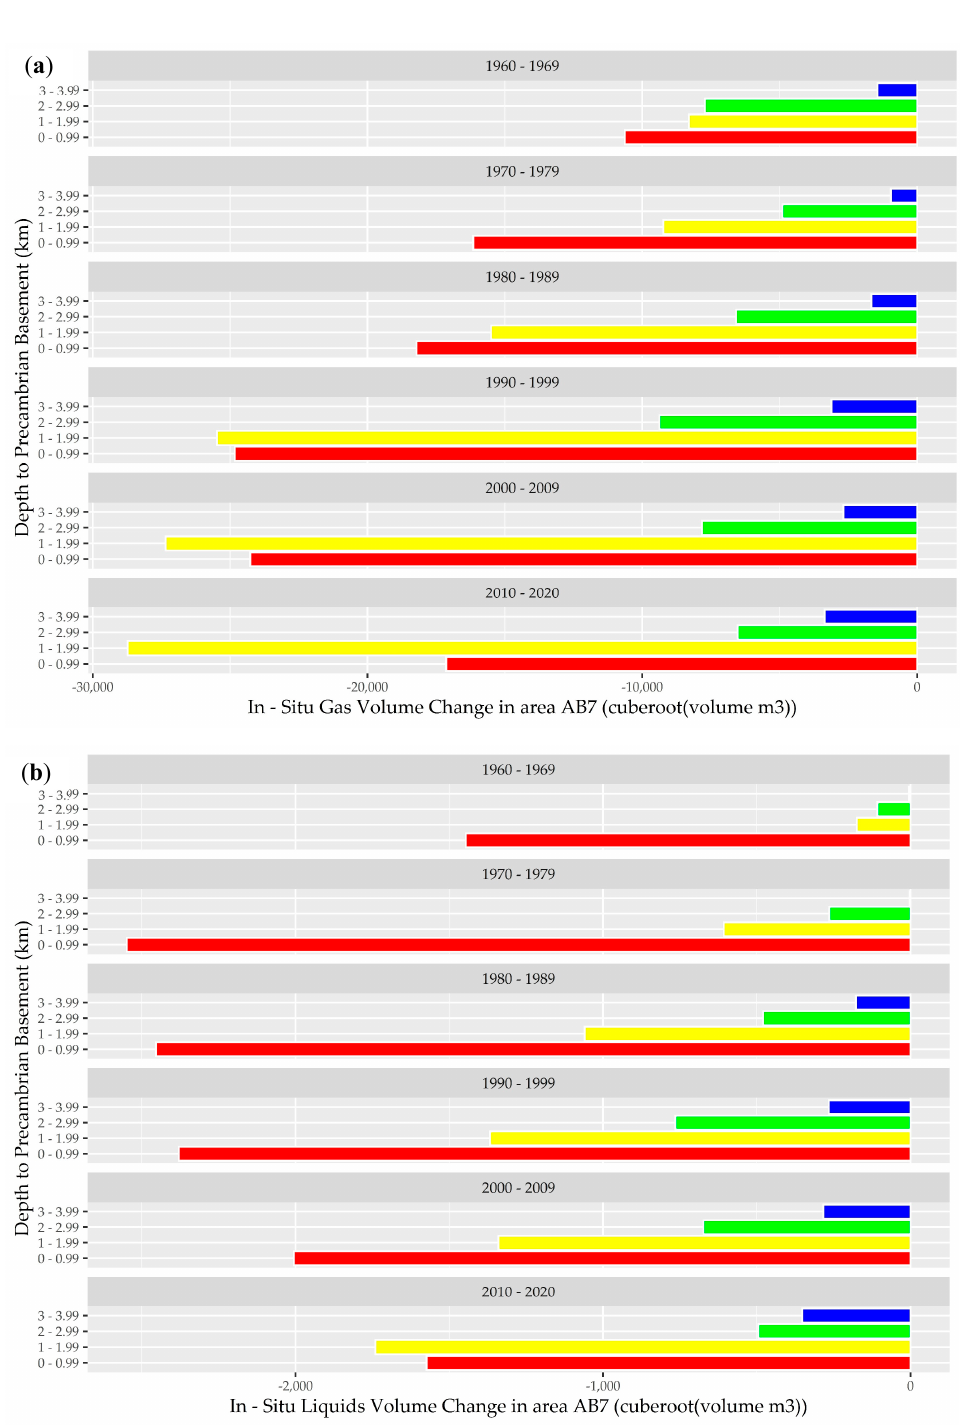
Figure 9. Calculated net in situ ( a ) gas and ( b ) liquid balance for AB7 over the period January 1960–December 2020. Red bars: <1 km depth from Precambrian basement; Yellow bars: 1–2 km depth from Precambrian basement; Green bars: 2–3 km depth from Precambrian basement; Blue bars: 3–4 km frm Precambrian basement. Source data extracted from geoLOGIC Systems databases ©